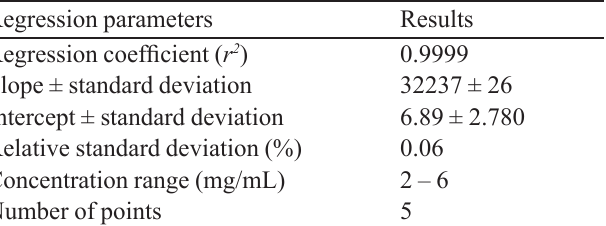
TABLE I – Results of the regression analyses obtained for the HPLC method of artemether quantitation Regression